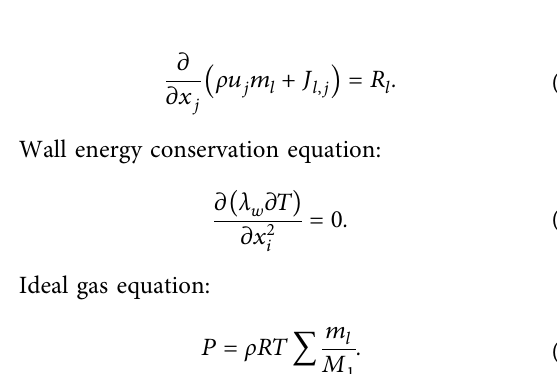
Figure 1: Schematic of the micro-combustor (units in